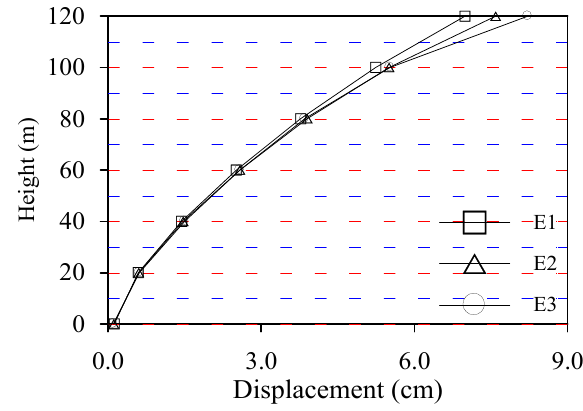
Fig. 6. The variation of maximum displacements on II-II section of the arch dam for Case E.